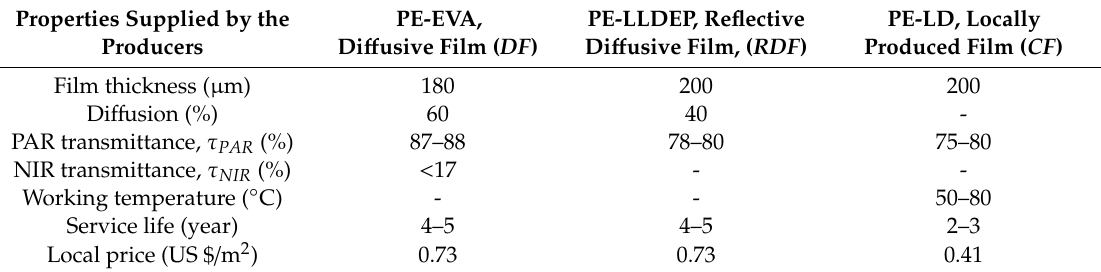
Table 1. Properties of the three films tested as they were supplied by the